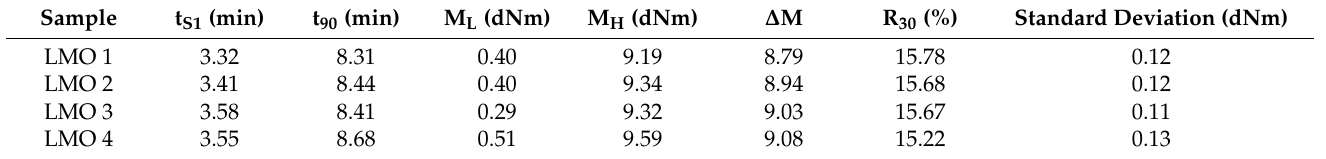
Table 5. Cure characteristics for different ratios of LMO:AO.